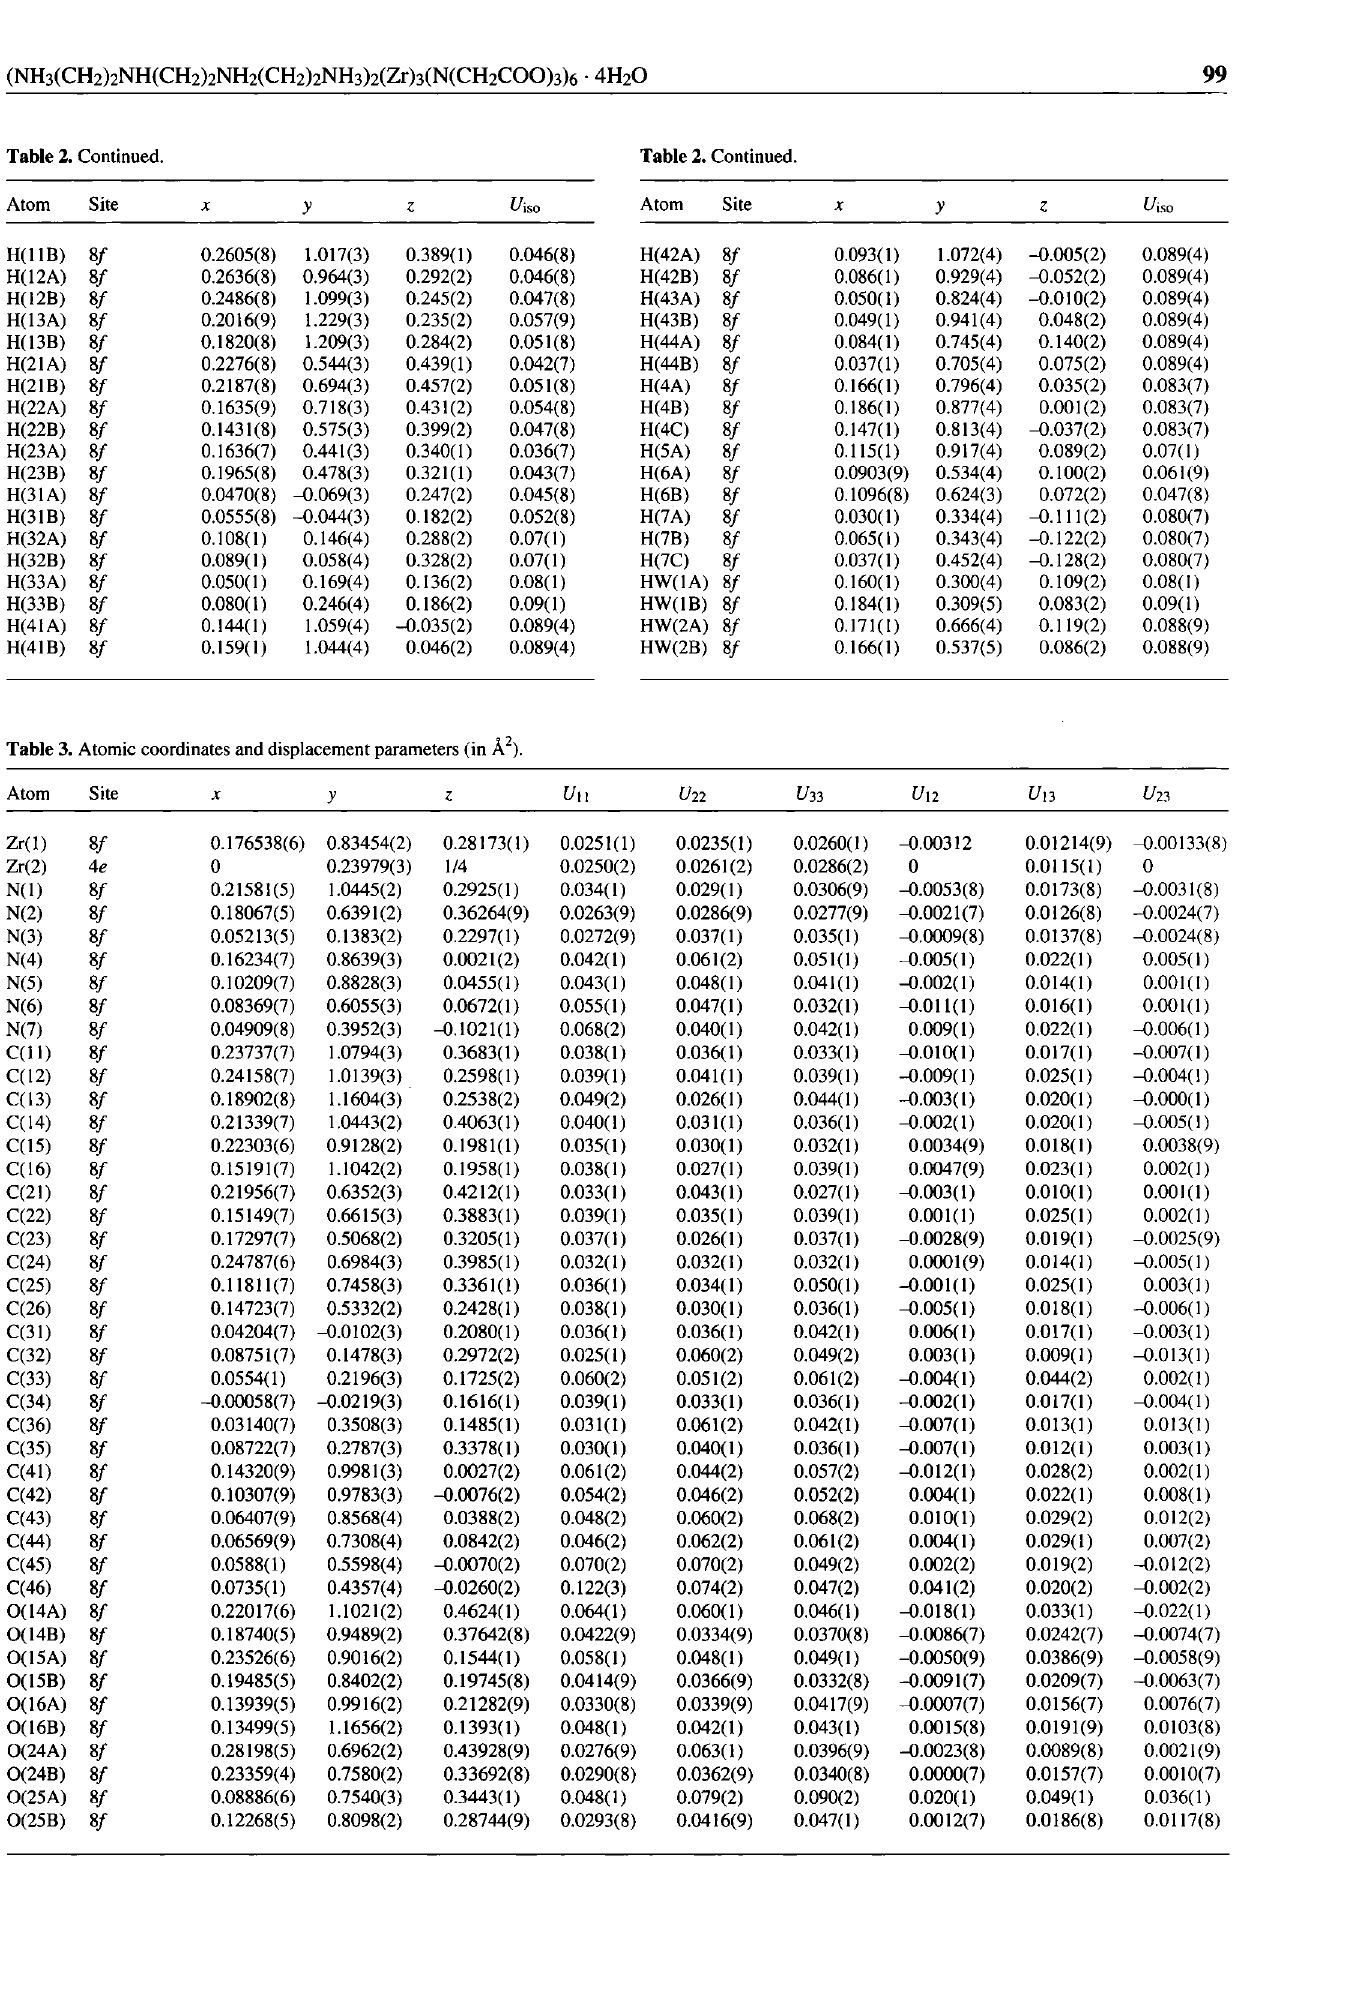
Table 3. Atomic coordinates and displacement parameters (in Ä 2